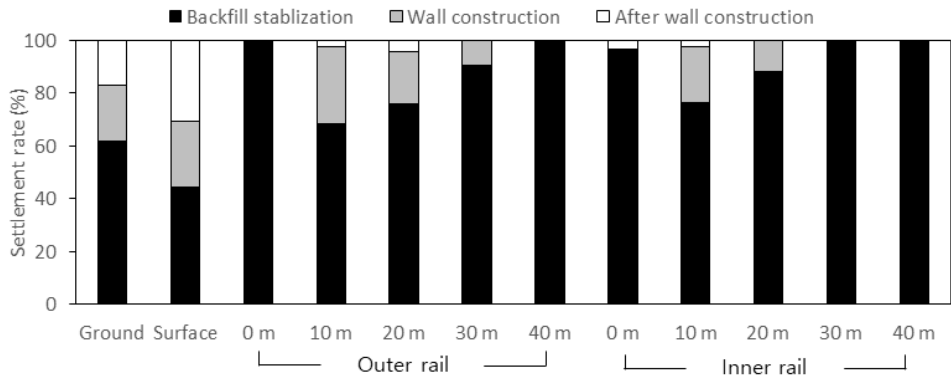
Figure 13. Settlement rate by period.